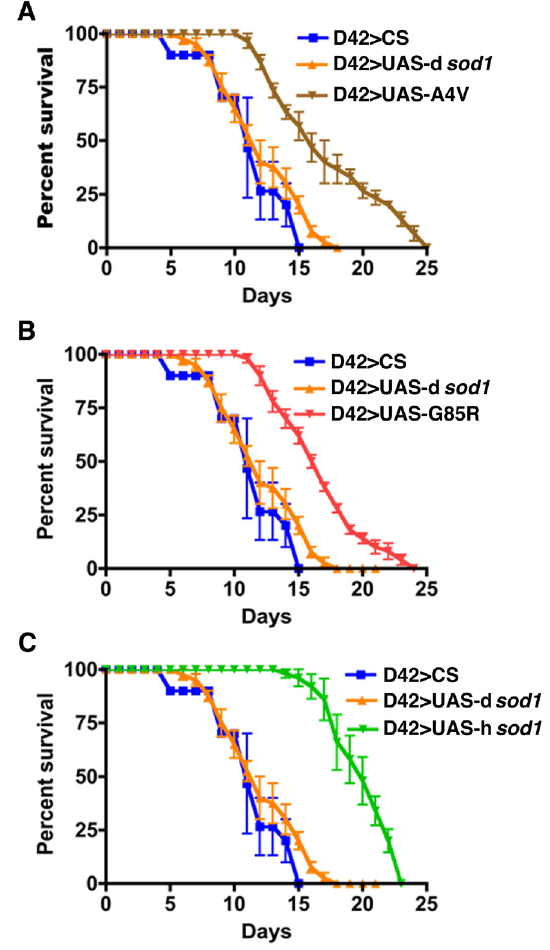
Figure 3. Human SOD1 overexpressed in motoneurons confers resistance to BMAA treatment. Shown are survival rates of 5 day-old male sod1 transgenic flies under 3 mM BMAA treatment (10 flies per vial). Panels A , B , and C represent the survival rate of